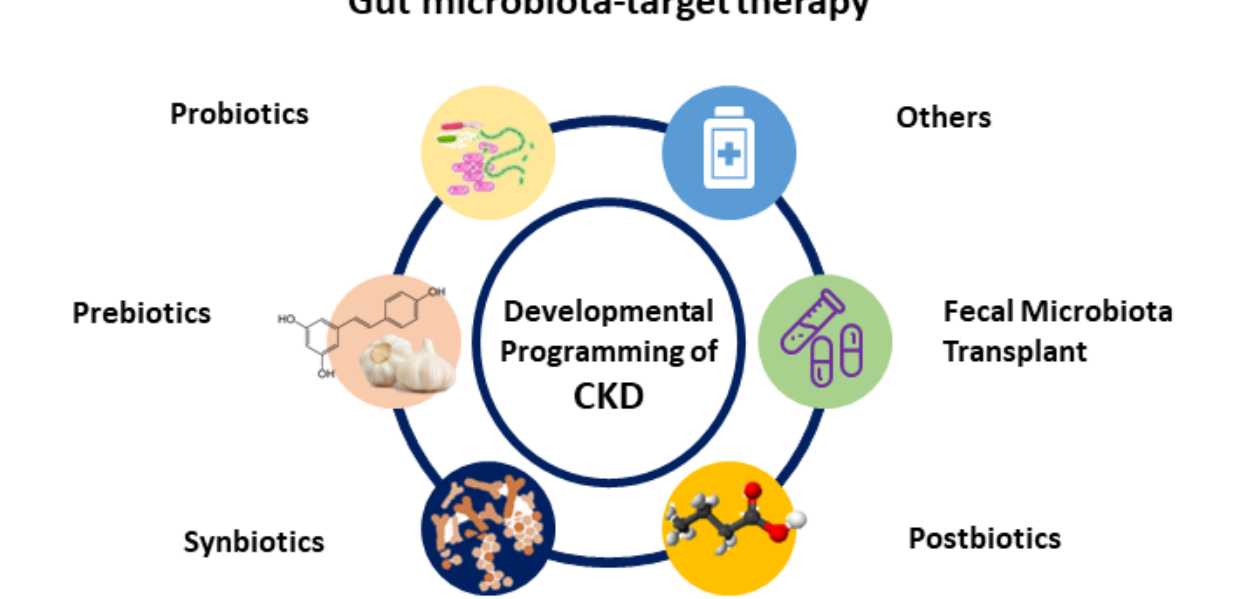
Figure 2. Schematic diagram of the potential gut microbiota-targeted therapy used for developmen- tal programming of chronic kidney disease. programming of chronic kidney